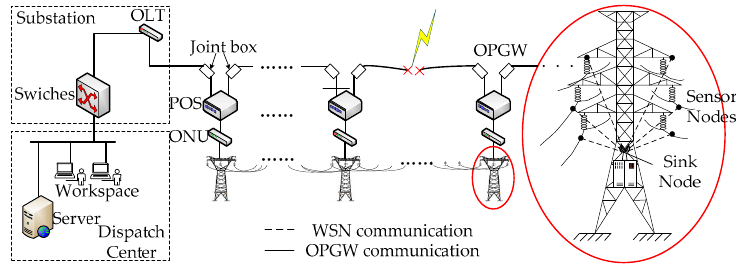
Figure 2. Practical structure of a wireless-sensor-networks (WSN)-based monitoring system.